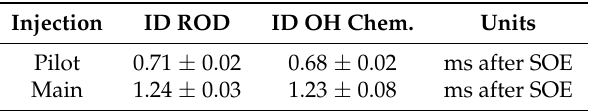
Figure 8. Correlation between ignition delays calculated with the traditional schlieren methodology and the rate of difference procedure from DBI movies for single injection cases and all boundary conditions tested. Table 3. Comparison of the start of combustion calculated with the rate of difference and with high-speed OH